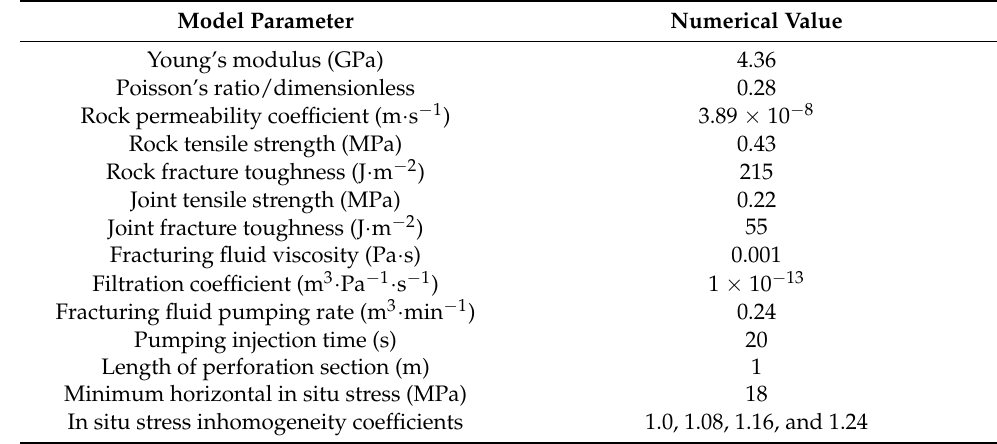
Figure 8. Probability distribution and fitting curve of the rock mechanics parameters in the coalbed methane. ( a ) Elastic modulus, ( b ) Poisson’s ratio. Table 2. Staged fracturing geometric model parameters of CBM reservoirs.